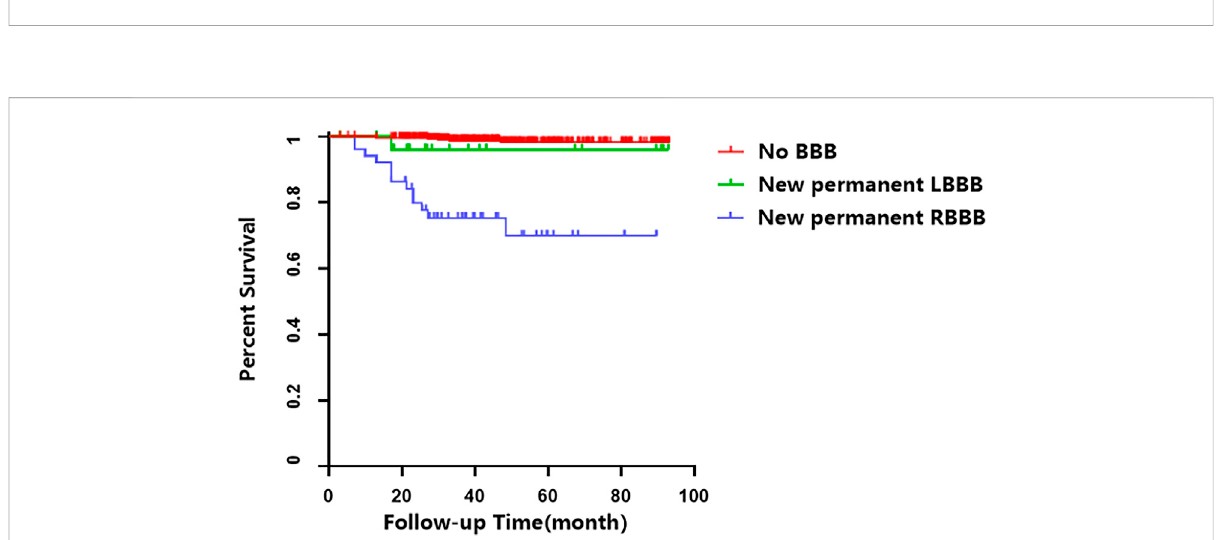
FIGURE 3 Cumulative survival analysis of all-cause mortality in patients with STEMI who underwent